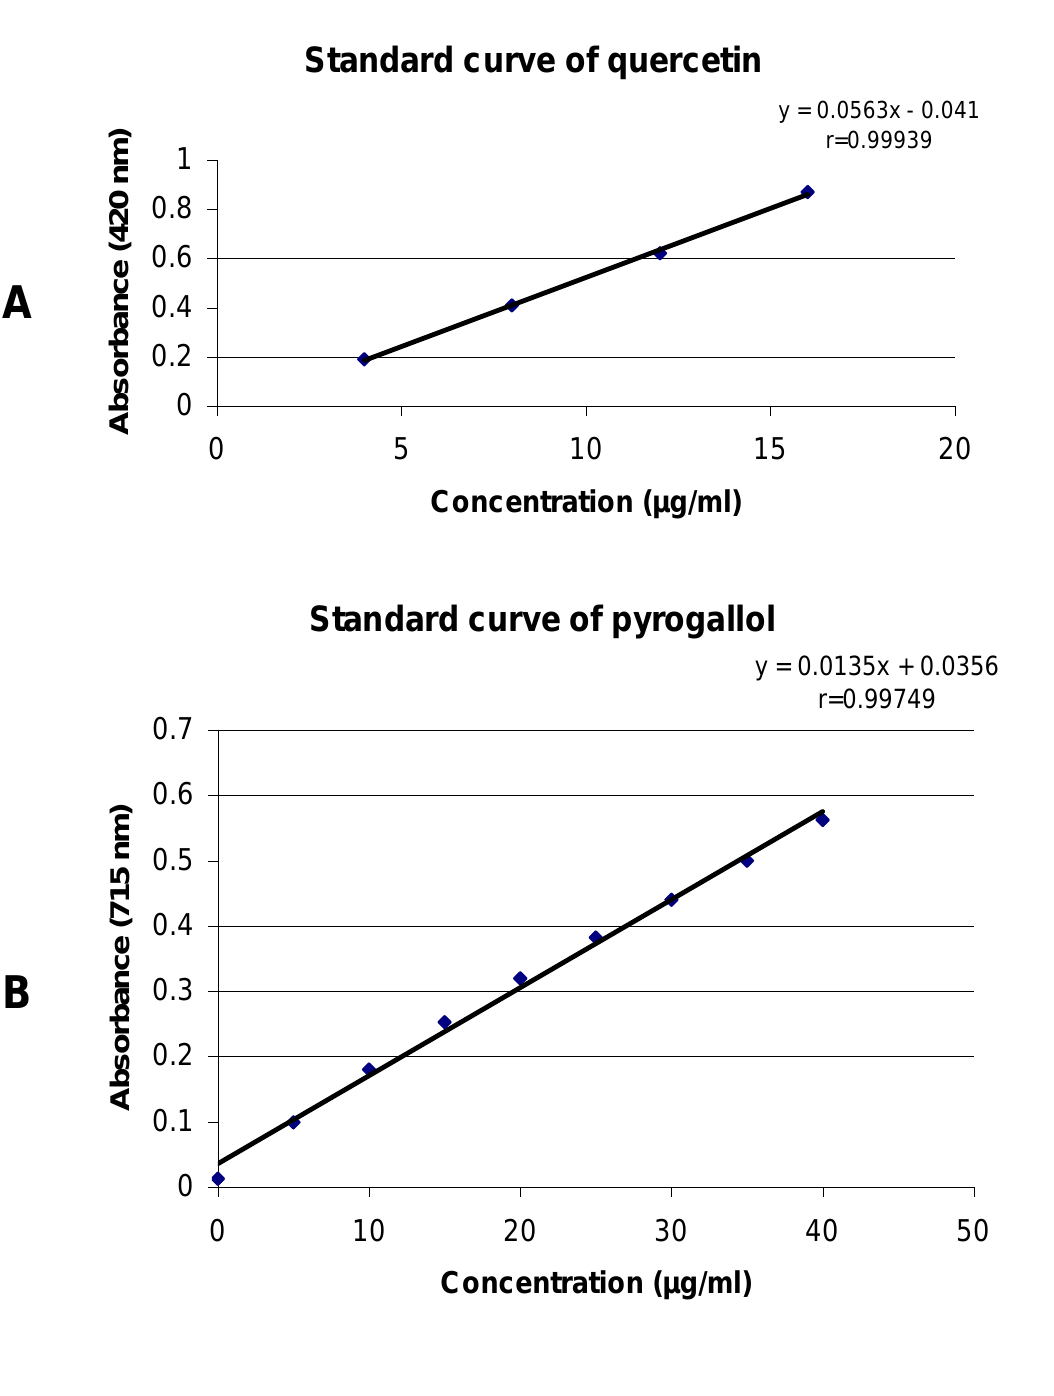
Figure 2: Standard curves for the flavonoid quercetin (A) and the phenolic compound pyrogallol (B). The content of these substances in the leaves of C. sylvestris was determined by